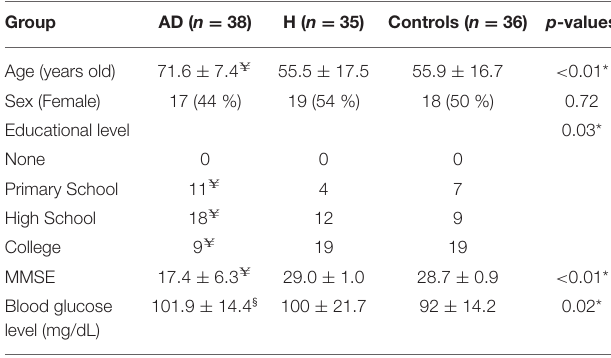
TABLE 1 | Characteristics of Alzheimer’s disease (AD), healthy (H) group patients and controls.